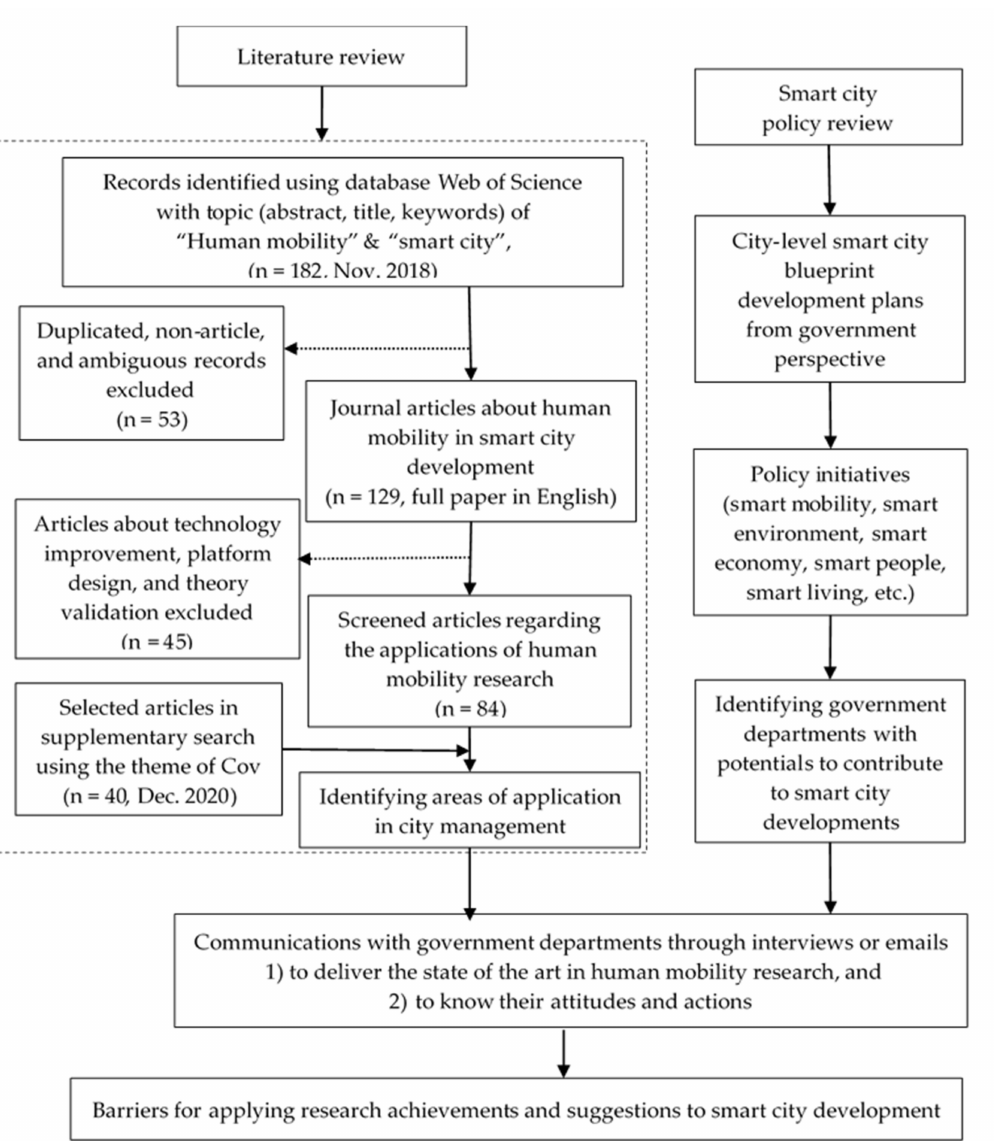
Figure 1. The framework for linking big data human mobility research with city-level smart city